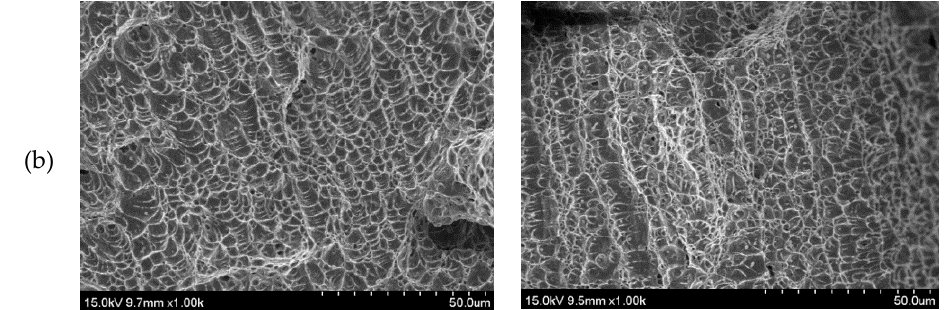
Figure 15. The fractographs of the notched specimens that were tested at room temperature: ( a ) a low magnification, and ( b ) a high magnification.